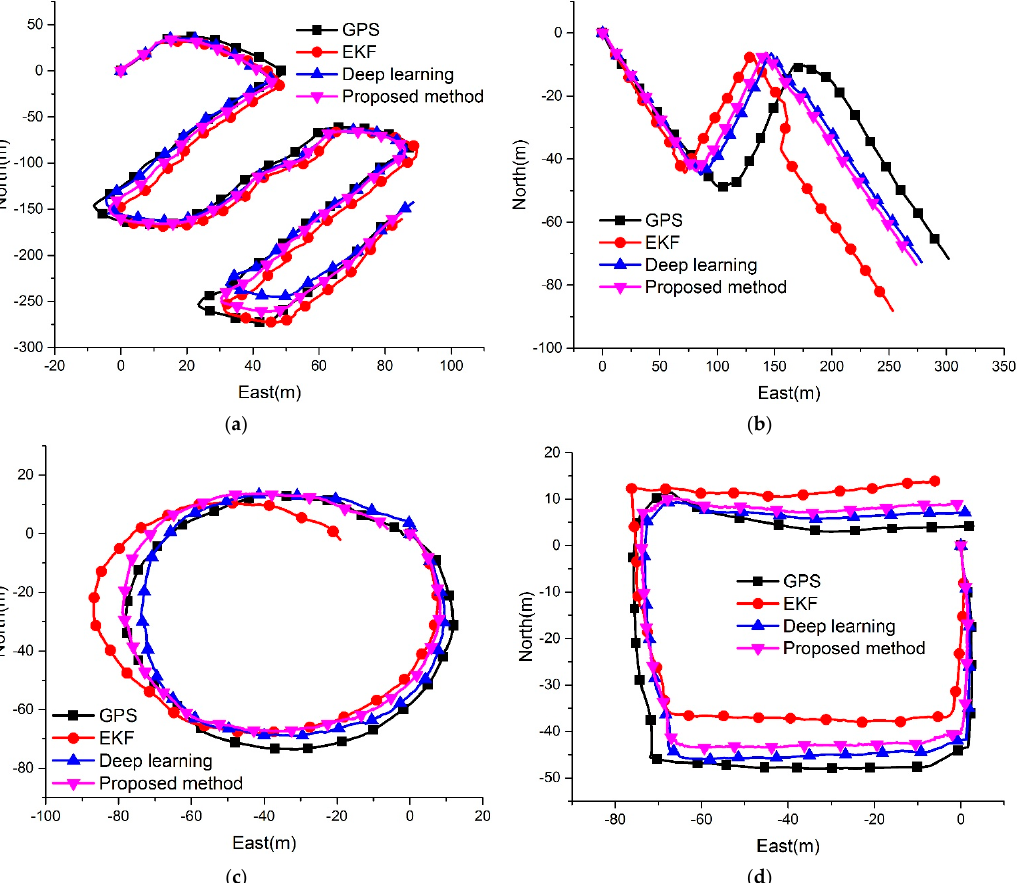
Figure 6. Four experimental results of the ground truth trajectory and the trajectories obtained using different methods based on field